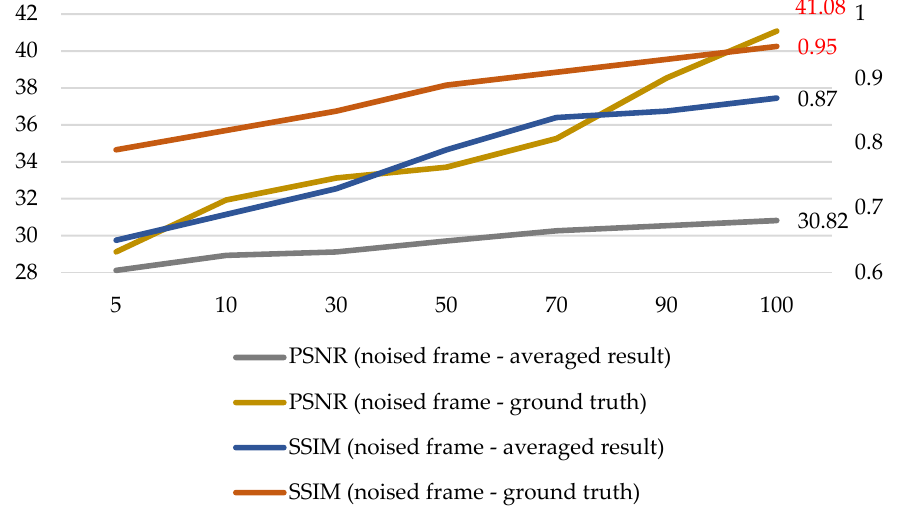
Figure 2. Qualitative relationship between the averaging number and the quantitative metrics.